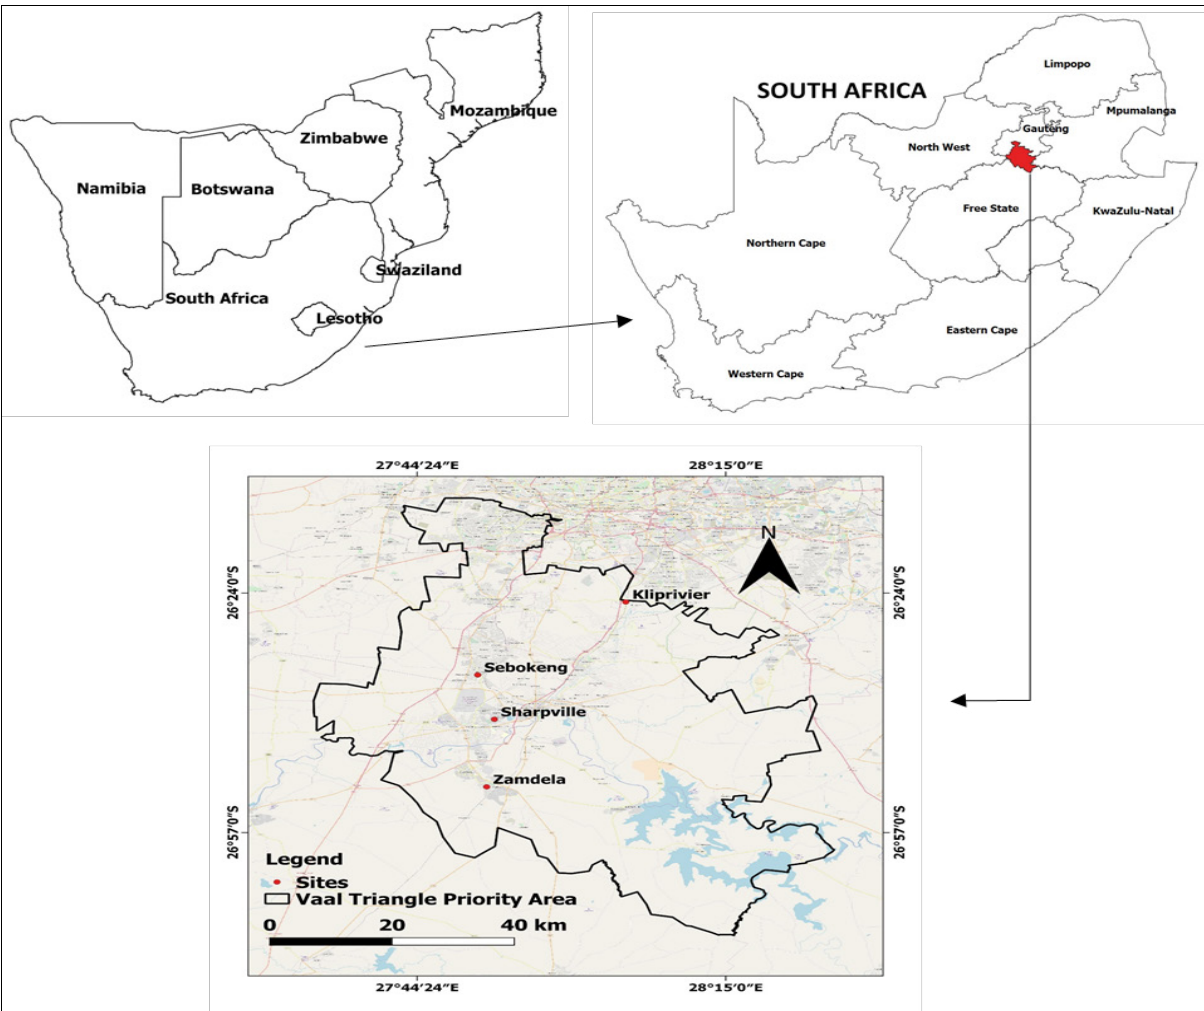
Figure 1: Study area map showing the location of the Vaal Triangle Airshed Priority Area (VTAPA) in South Africa and the four sampling sites within the